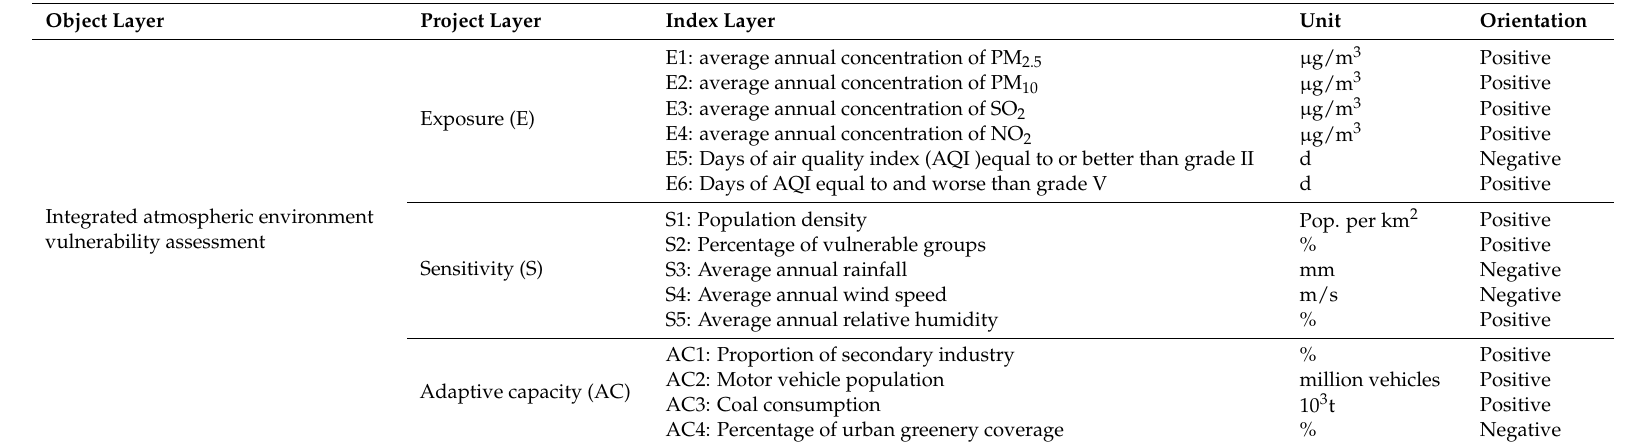
Table 1. Atmospheric environment vulnerability assessment indices of the BTH